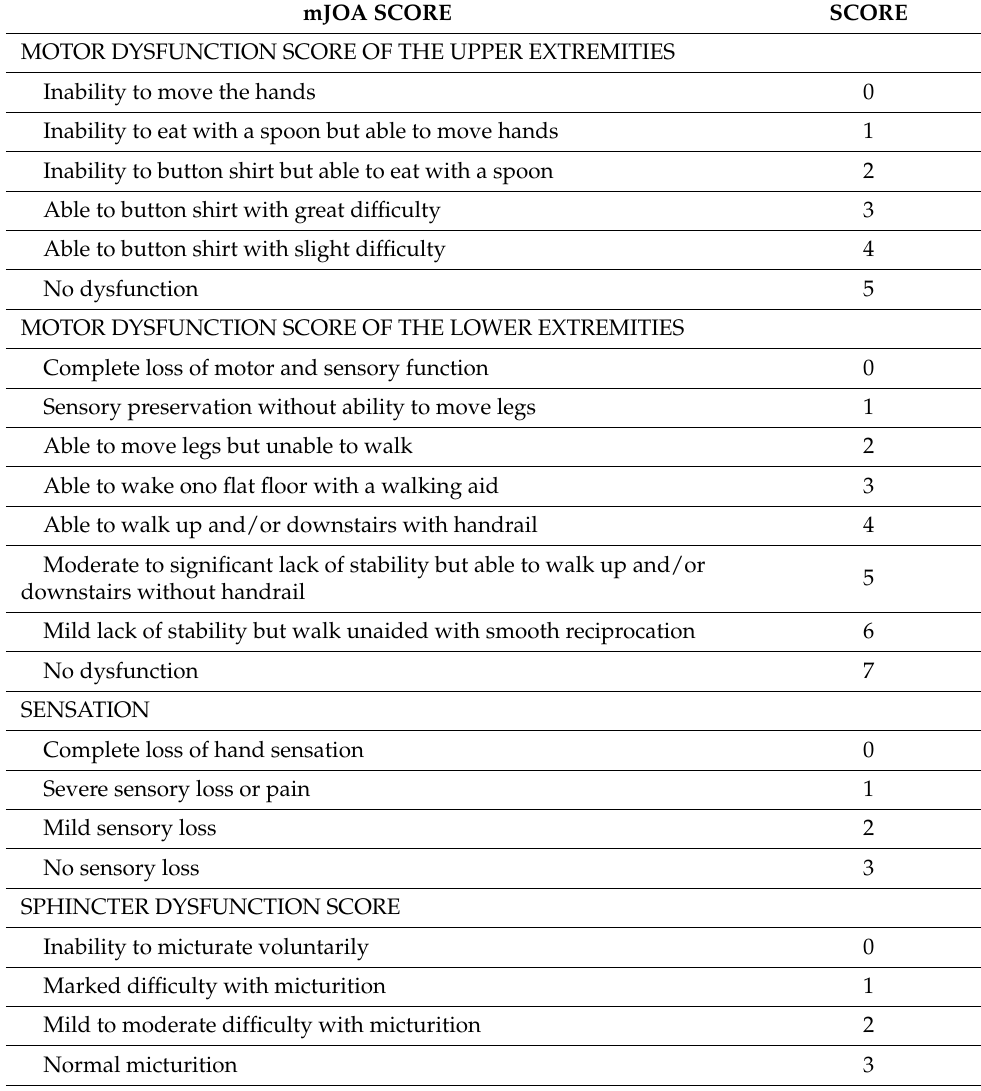
Table A1. mJOA score. Clinical conditions scored in the mJOA score and their value [6,7].